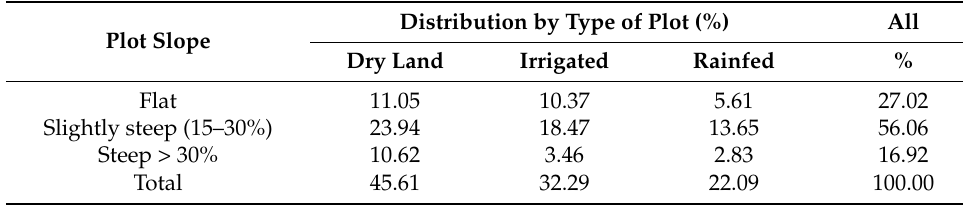
Table 2. Total owned plots by slope and use (hectare). Plot Slope Estate Crops Horticulture Rice All Flat